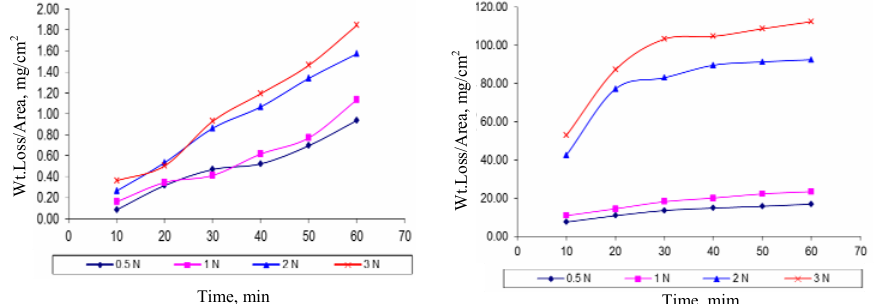
Figure 1. Effect of concentration of sulphuric acid on corrosion rate.